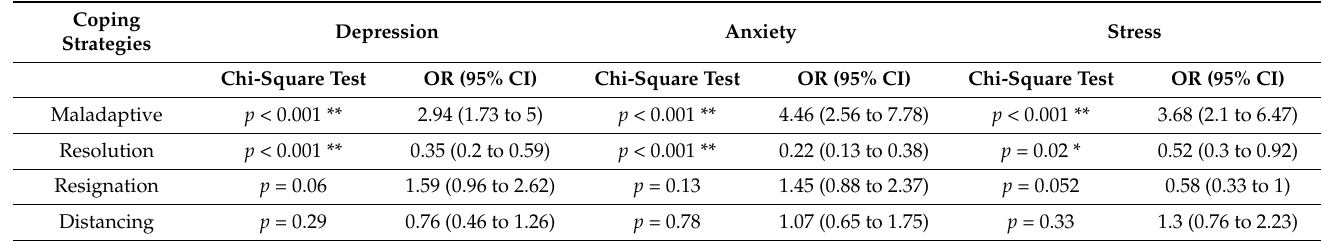
Table 4. Coping strategies and mental health